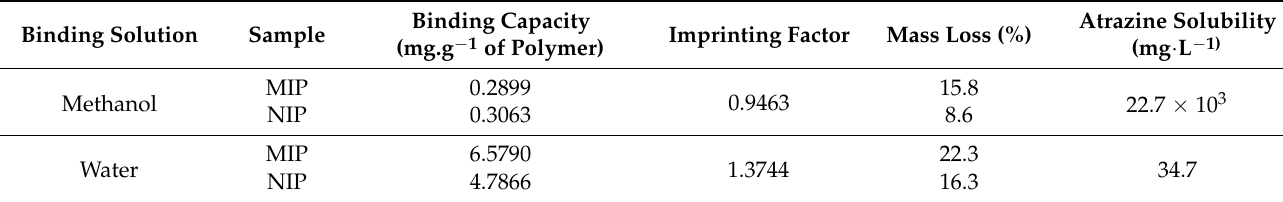
Table 2. Absorbed amounts of Atr by MIP and NIP and imprinting factors for different binding solutions. Note: Polymer synthesized using a constant molar ratio of template:crosslinker:monomer.